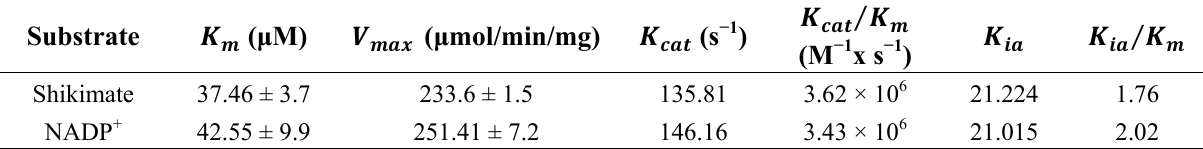
Table 1. Kinetic parameters for